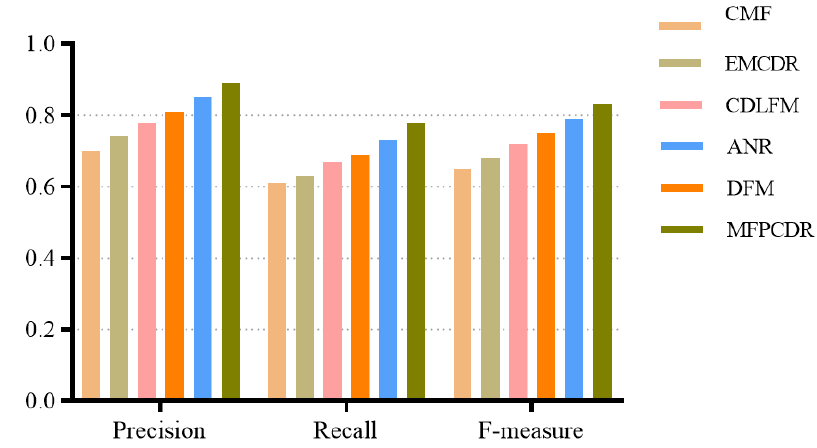
Figure 6. Precision, Recall, and F-measure experimental results graph. Table 3. Precision, Recall, and F-measure experimental results table.